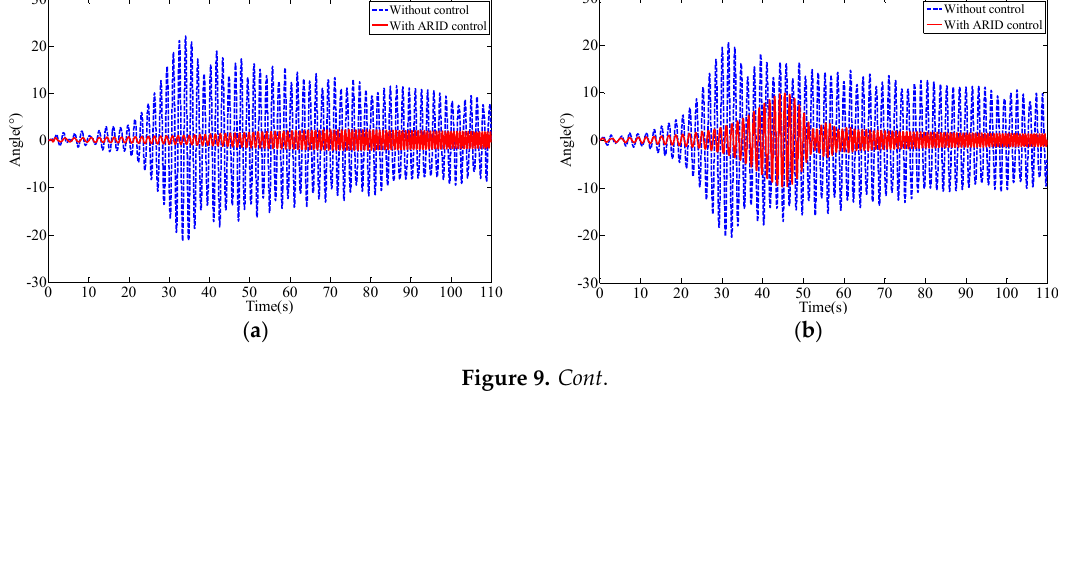
Without control(Experiment) With ARID control(Experiment) Without control(Numerical analysis) With ARID control(Numerical analysis)